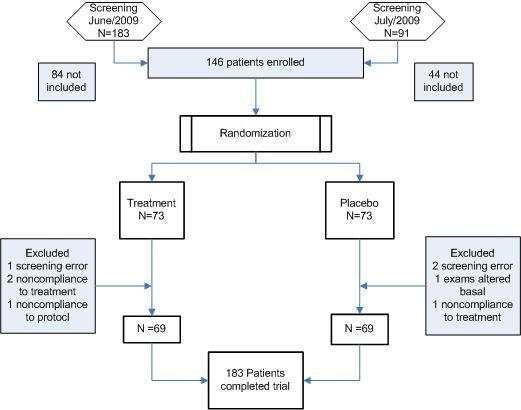
Study flowchart.